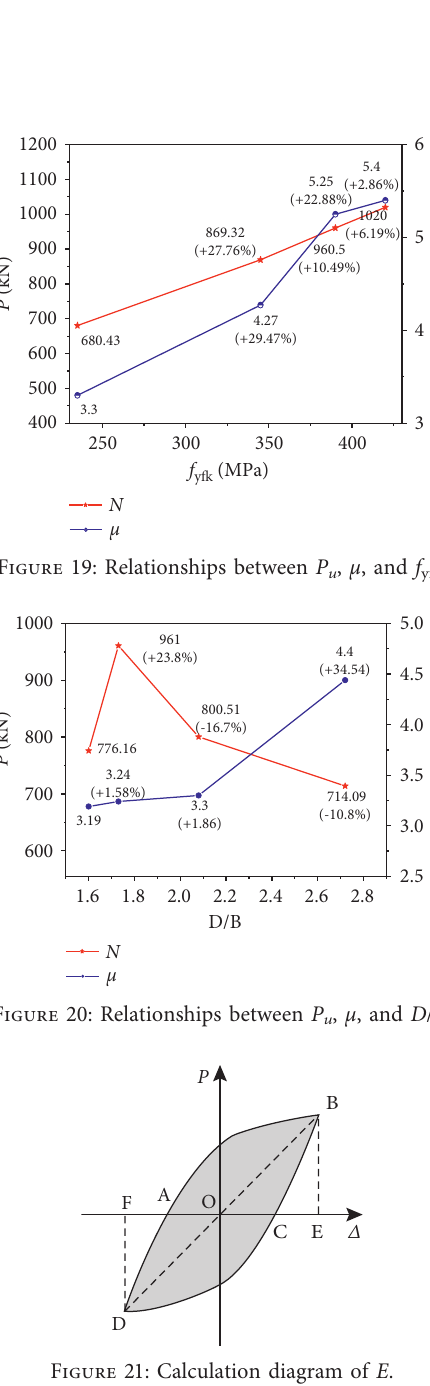
Figure 21: Calculation diagram of E